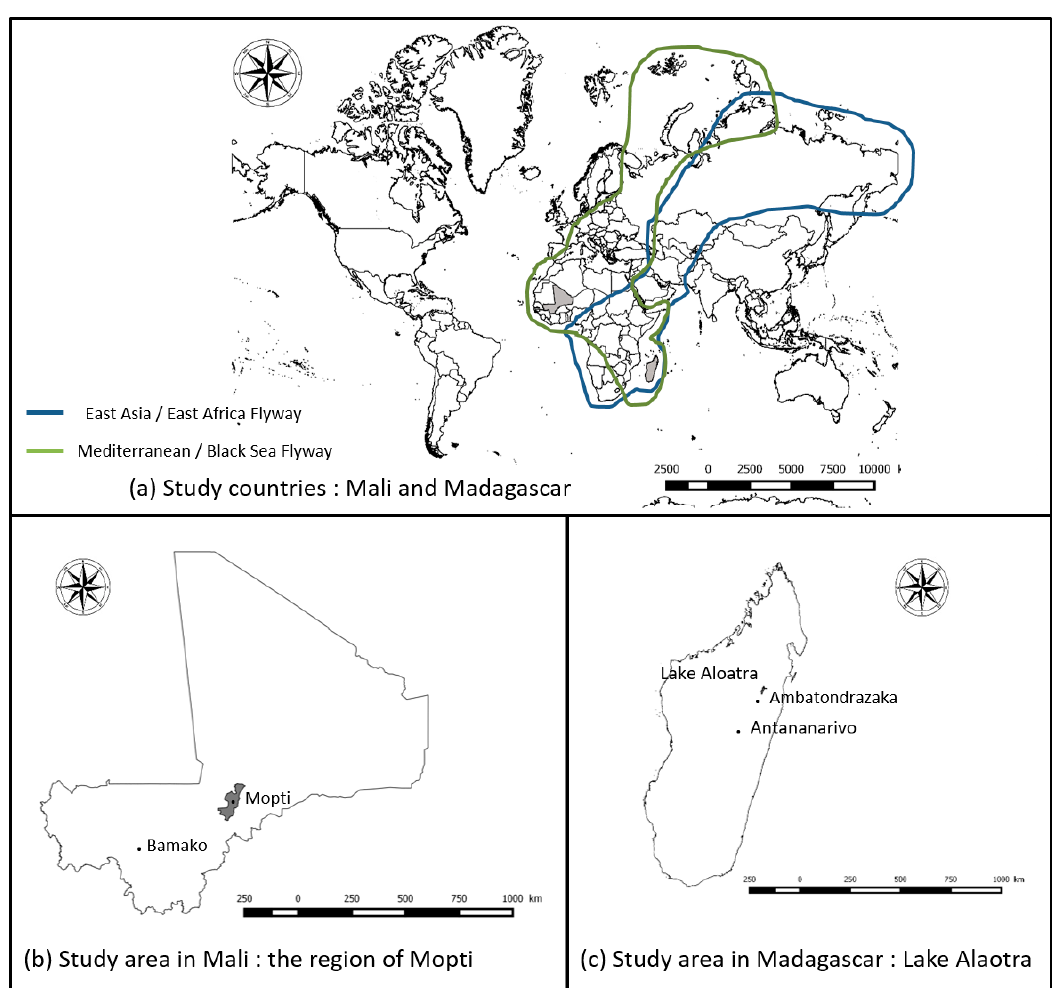
Figure 1. ( a ) Study countries and bird migration pathways (Source: BirdLife International https://www.birdlife.org/), ( b ) study area in Mali: the region of Mopti, and ( c ) study area in Madagascar: Lake Alaotra.